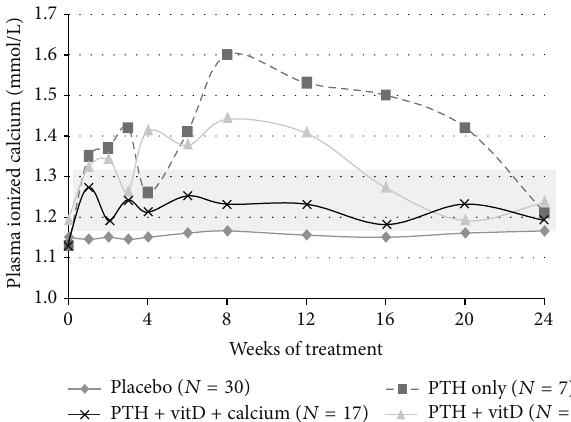
Figure 1: Results from a randomized controlled study on effects replacement therapy versus conventional treatment on of PTH 1 – 84 plasmaionizedcalciumlevels.Patientsintheplacebogroupreceived placebo injections in combination with conventional therapy (cal- cium supplements and activated vitamin D analogues). Data are stratified by whether patients at the end of study were managed on treatment with PTH alone (PTH only), PTH plus activated vitamin D (PTH + VitD), PTH plus activated vitamin D and calcium supplements (PTH + VitD + calcium), or placebo. The background light gray square indicates the reference range (1.18–1.32 mmol/l). Reproduced with permission from JBMR [17].